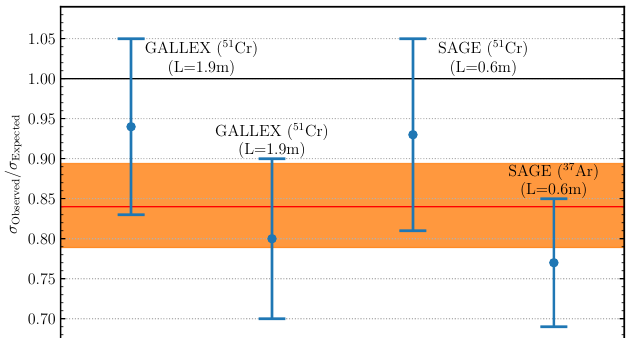
Figure 7: The 71 Ga ν capture cross section as measured by the GALLEX [ 21 ] and e SAGE [ 22,23 ] experiments at short baselines L , with neutrinos coming from different radioactive sources (in parentheses). All the data points consistently sit below the theoretical prediction (in black): the measured average and its error are shown in red and orange, respectively. The two GALLEX data points correspond to measurements with two different 51 Cr